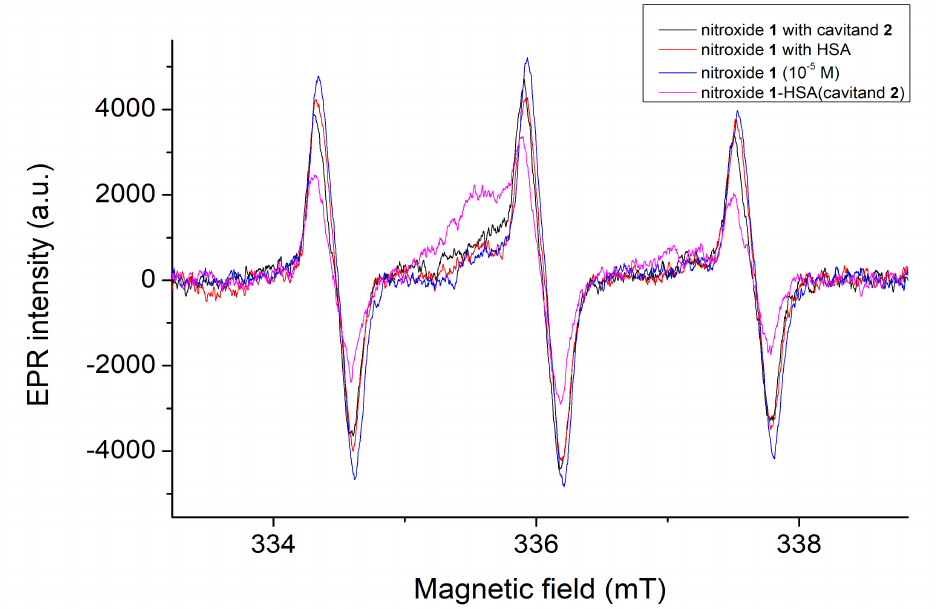
Figure 9. The effect of presence of HSA and cavitand 2 on the free nitroxide 1 ( left ) and OMe derivative 6 ( right ) fluorophore concentration.